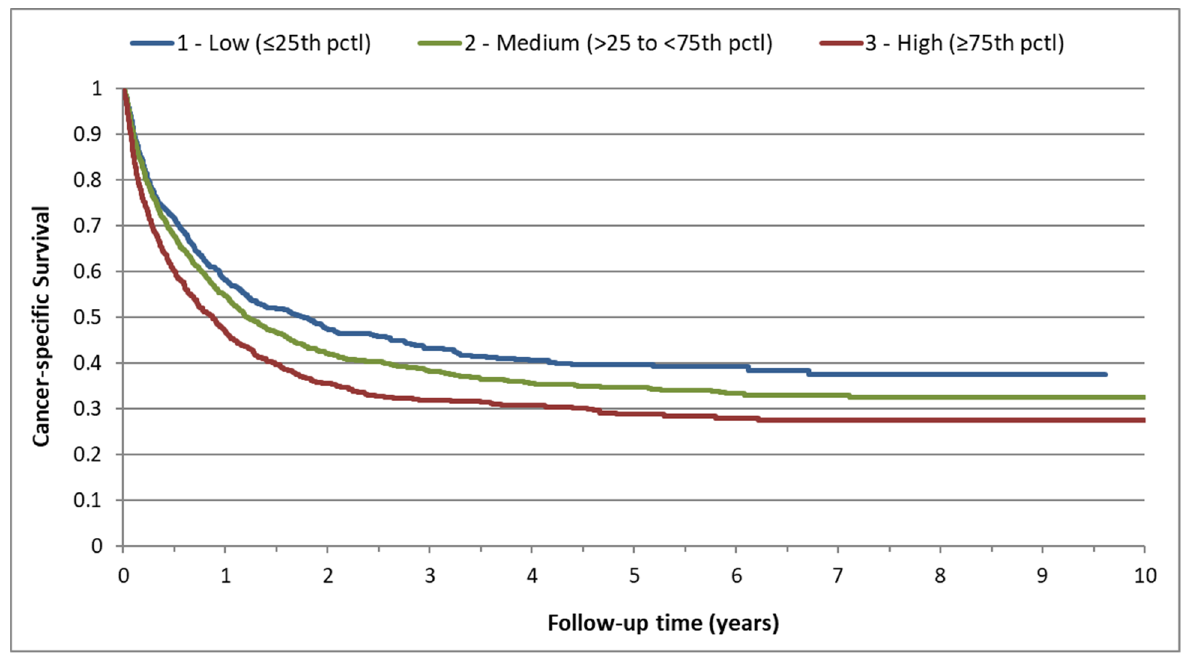
Figure 1. Cancer-specific survival by baseline platelet count category, for select cancers. ( a ) All cancers ( n = 112,231); ( b ) colon ( n = 17,259); ( c ) lung ( n = 20,583); ( d ) breast ( n = 9857); ( e ) prostate ( n = 8587); ( f ) ovary ( n = 3085); ( g ) stomach ( n = 3365).